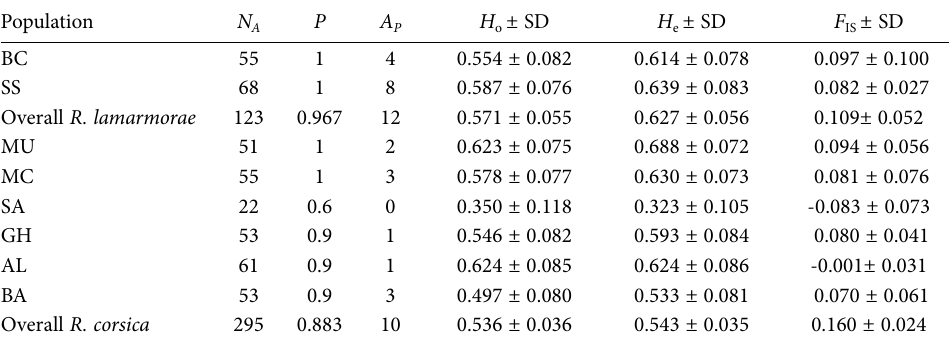
Table 3. Genetic diversity parameters inferred from microsatellite analysis. N A total number of alleles across loci, P proportion of polymor- phic loci, A P number of private alleles, H o observed heterozygosity, H e expected heterozygosity, F IS fixation index; SD, standard deviation. For abbreviations of populations see Table